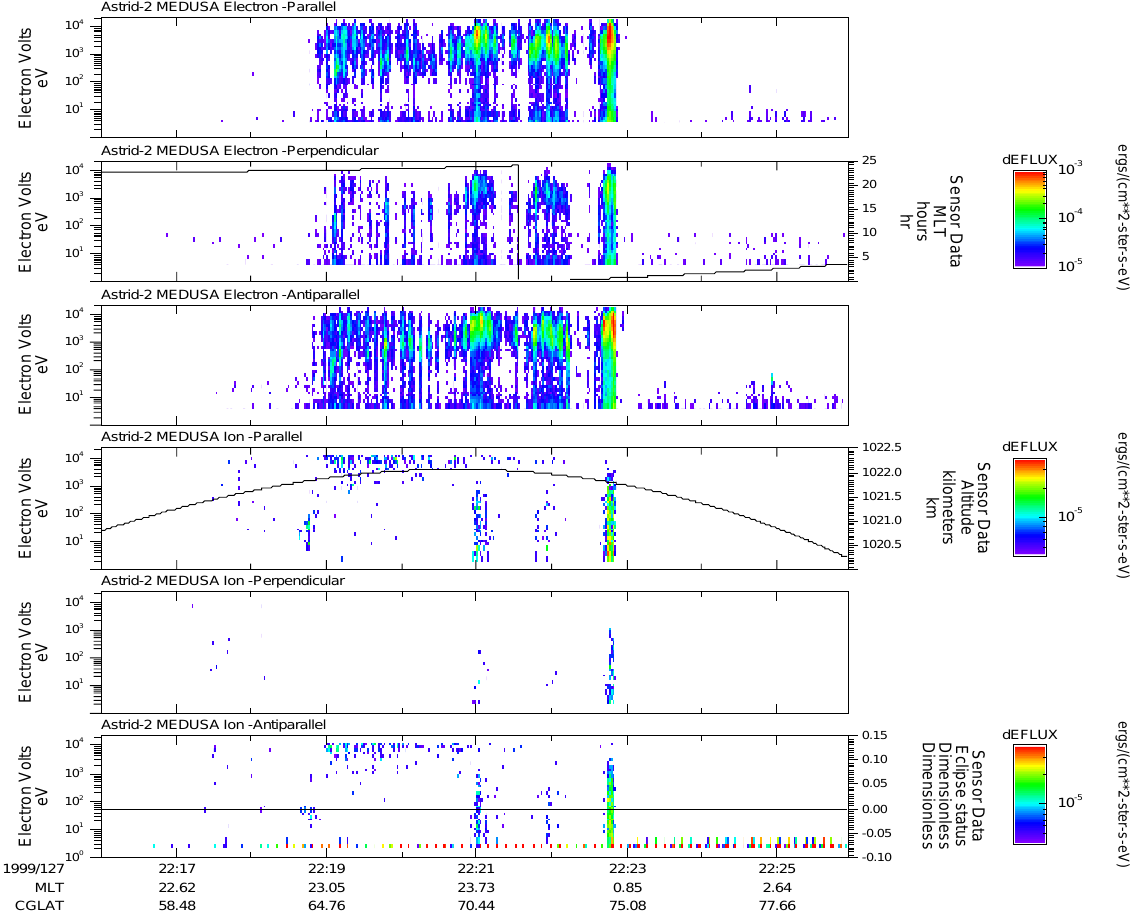
Fig. 4. Energy time spectrograms of electrons and ions measured by the Astrid-2 particle instrument during the nightside auroral oval crossing between 22:16 UT and 22:26 UT on 7 May 1999. For more information see